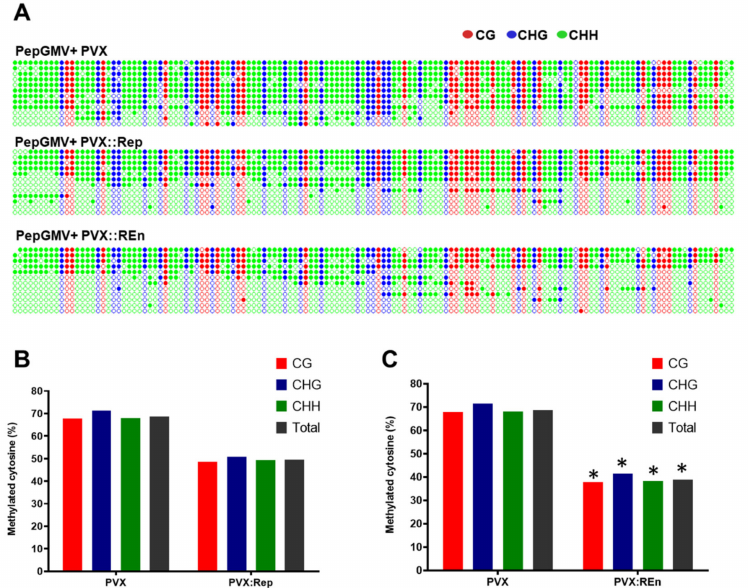
Figure 5. PepGMV DNA methylation level. PepGMV recovered plants were inoculated with PVX expressing PHYVV Rep or REn genes. Ten days after PVX inoculation apical leaves were collected for minichromosome extraction. DNA present in the minichromosomes was treated with bisulfite and used in a PCR assay to amplify and clone the viral fragment shown in Figure 2. Twelve clones per treatment were sequenced. ( A ) Cytosine methylation detected in individual clones. Dot graphics represent all cytosines present, 138 in total with CG (30) in red, CHG (28) in blue, and CHH (80) in green, filled circles indicate a methylated cytosine (mC). ( B , C ) Histograms show the percentage of mC residues in di ff erent sequence contexts. A Student’s t -test was performed using individual clones as data points. No significant di ff erence was detected between control samples inoculated (PVX) and samples inoculated with PVX:Rep ( B ). On the other hand, a significant di ff erence was observed between the control samples (PVX) and samples inoculated with PVX:REn ( C ) and it is indicated as * p <